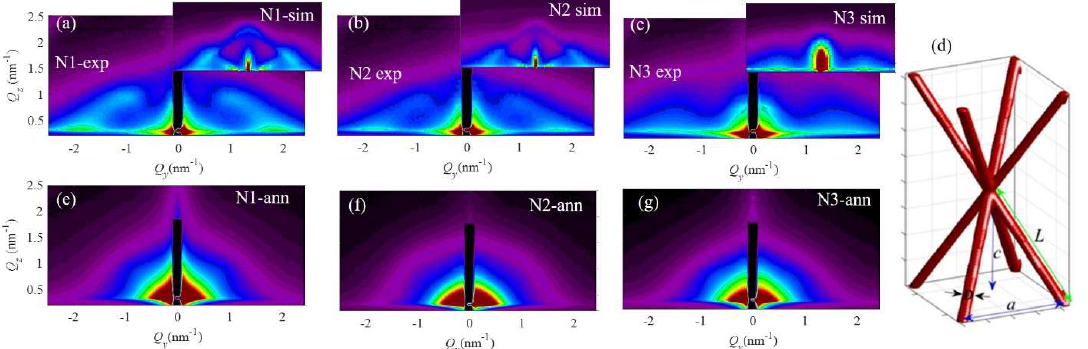
Figure 2. ( a – c ) GISAXS maps, and their simulations in the insets, of the as-grown films. ( d ) Model of the QW network and its main parameters. ( e – g ) GISAXS maps of the annealed films, showing the destruction of the QW regular network that was present before annealing.